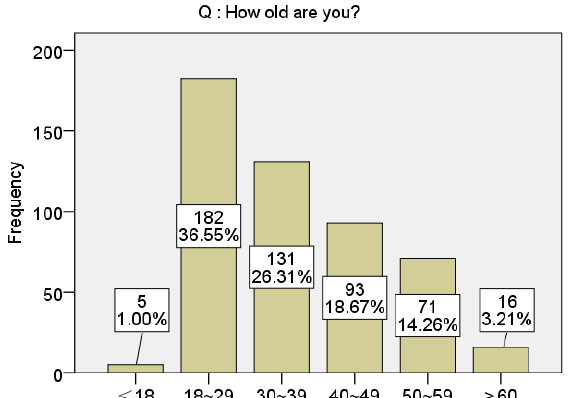
Figure 7. Gender frequency.